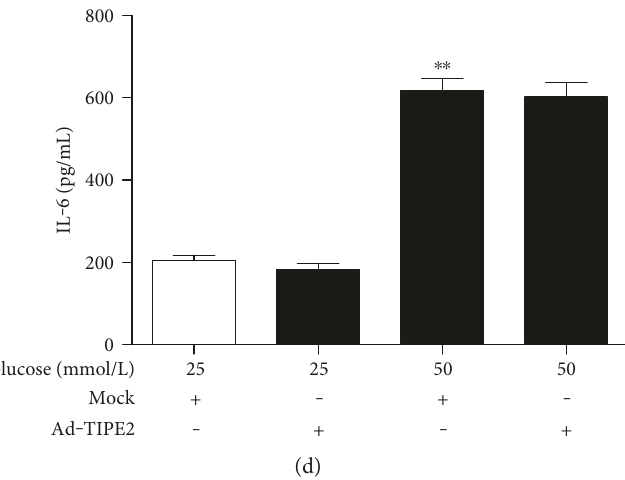
Figure 4: E ff ects of TIPE2 on cytokine secretion by THP-1 cells. The concentrations TNF- α and IL-6 in the culture supernatant from di ff erentiated THP-1 cells were determined by ELISA. Under high glucose conditions (50 mmol/L), siTIPE2 infection exacerbated the increased TNF- α and IL-6 concentrations (a, c), while Ad-TIPE2 infection reversed the increased TNF- α concentration and had no obvious e ff ect on the increased IL-6 release in di ff erentiated THP-1 cells (b, d). ∗∗ P < 0 001 versus 25mmol/L glucose alone. # P < 0 05 versus 50mmol/L glucose + siTIPE2. ## P < 0 001 versus 50 mmol/L glucose +Ad-TIPE2. The data are shown as mean ± SEM of 3 separate experiments.